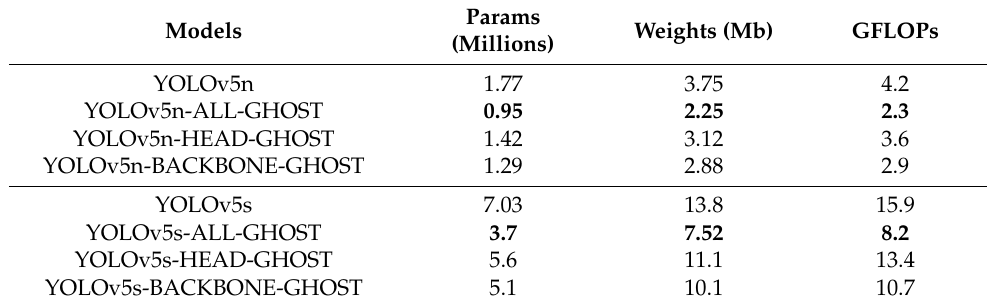
Table 5. Parameters of each